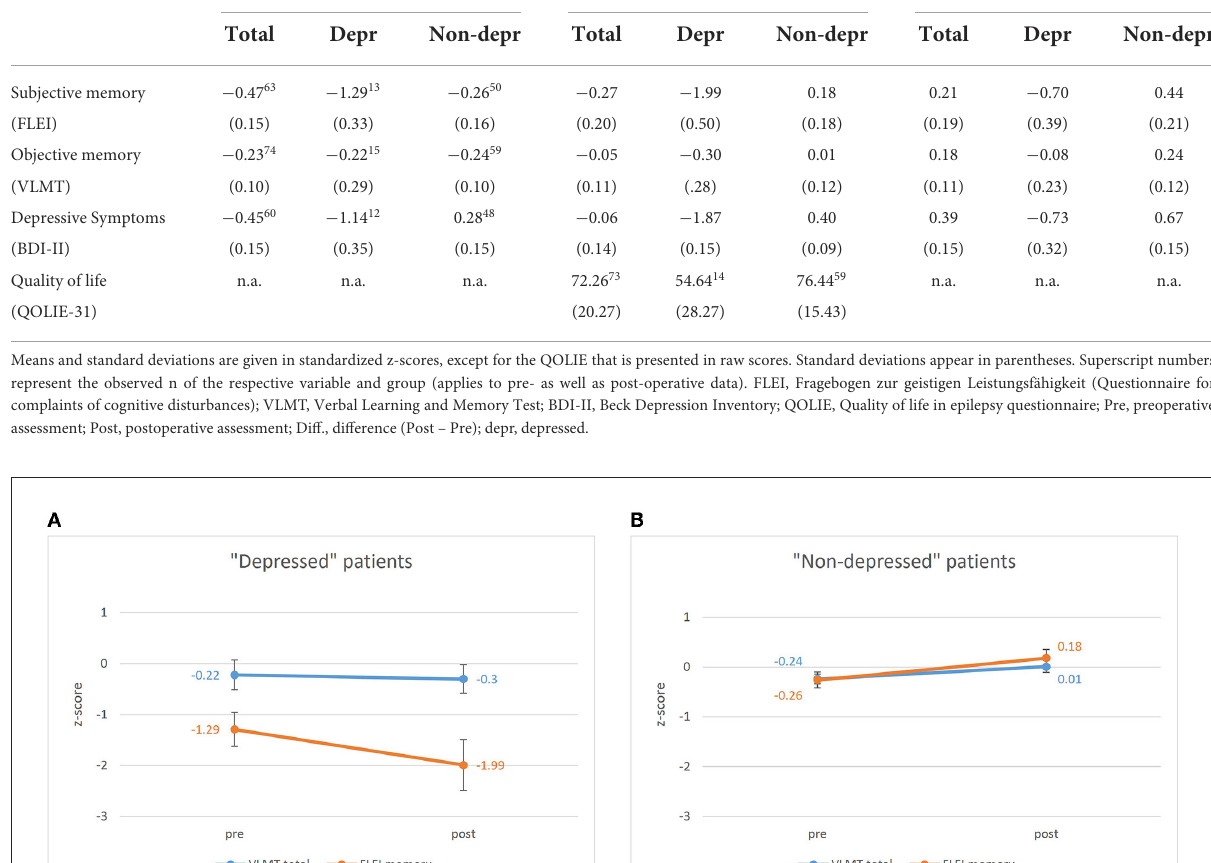
TABLE 2 Pre- and postoperative mean outcomes and mean differences in subjective and objective memory performance as well as severity of depressive symptoms and quality of life.